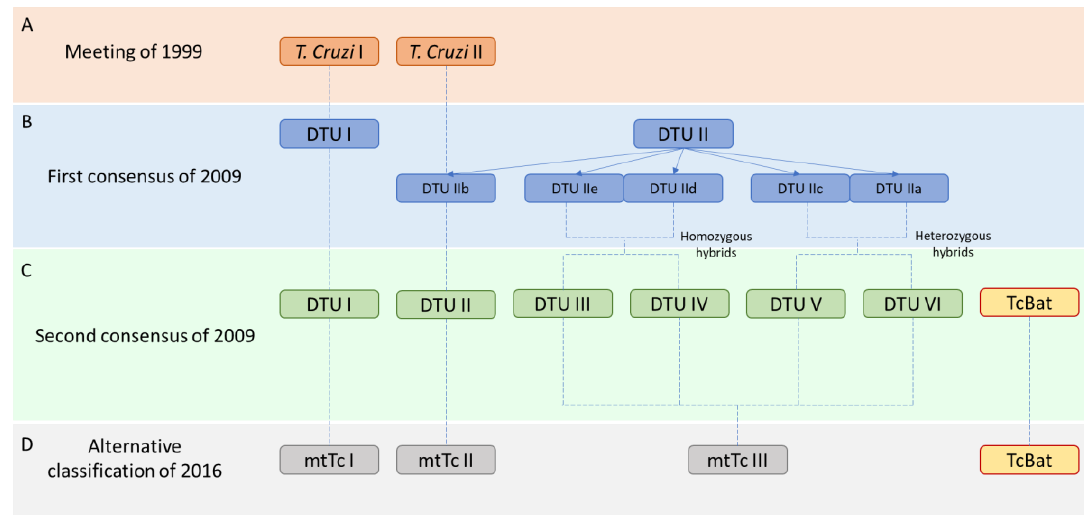
Figure 1. Different classifications of Trypanosoma cruzi since 1999. ( A ) Classification of the meeting of 1999. ( B ) First consensus classification of 2009. ( C ) Second consensus classification of 2009. ( D ) Alternative classification proposed in 2016.